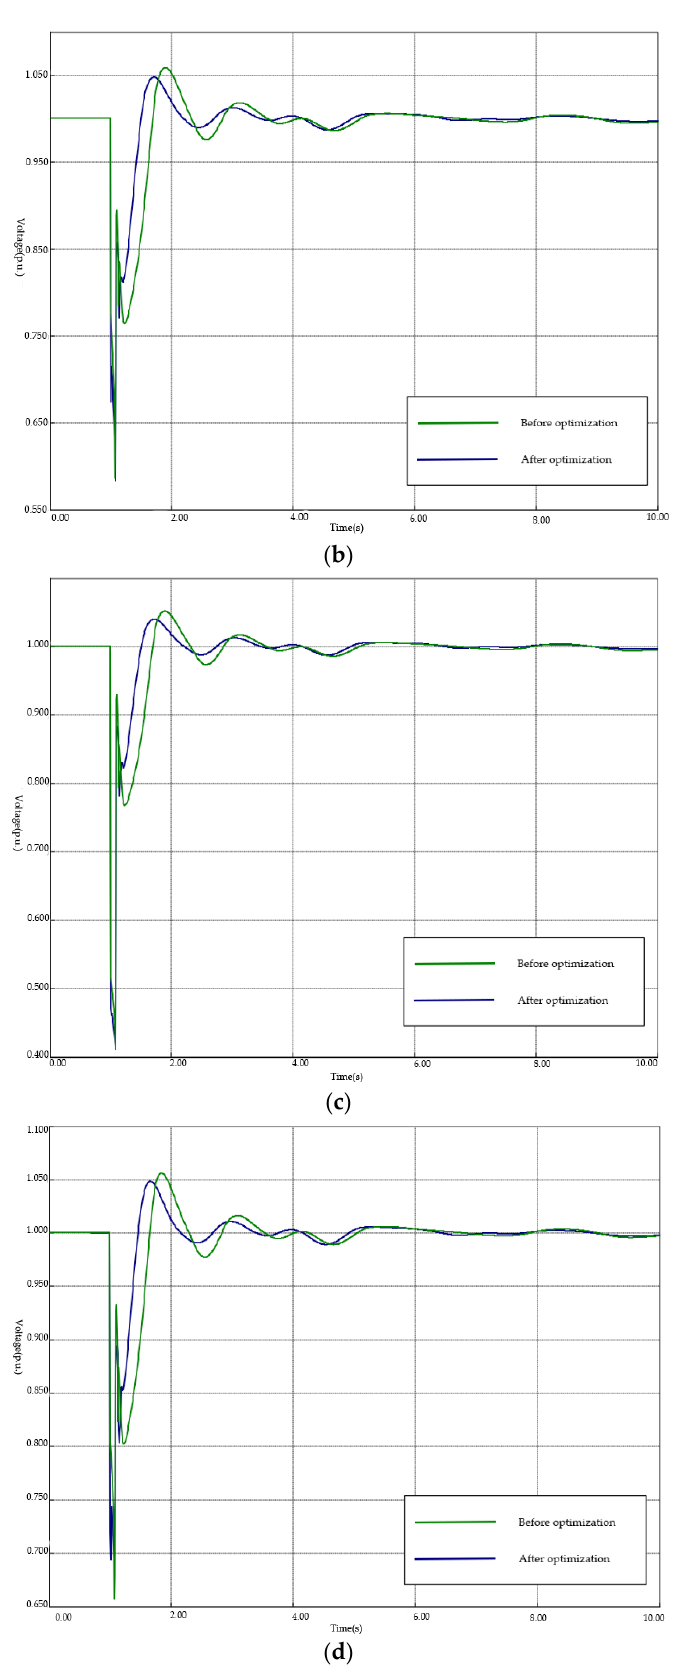
Figure 7. Transient voltage curves of inverter buses: ( a ) QDC ‐ L; ( b ) QDC ‐ H; ( c ) LDC ‐ L; ( d ) LDC ‐ H.